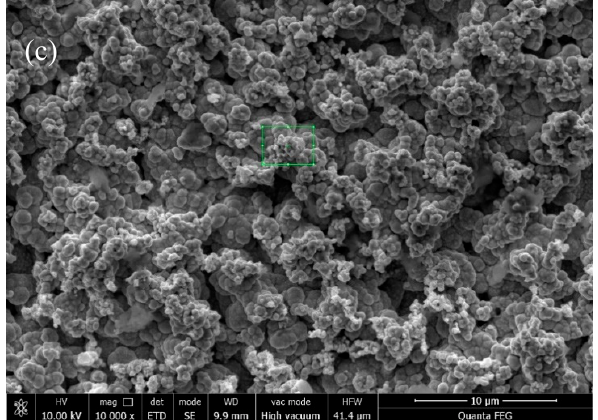
Figure 5. Morphology of composite coatings prepared by different plating methods (×10,000): ( a ) DC electroplating, ( b ) single-pulse plating, ( c ) double-pulse plating.